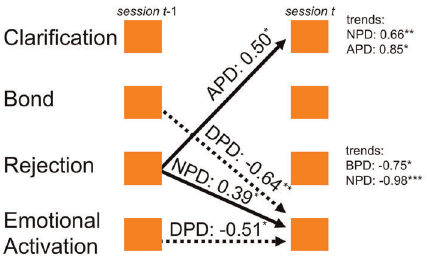
Figure 4. Significant time-lagged associations in diagnostic subsamples. Significant time-lagged associations in diagnostic sub- samples: BPD, borderline PD (n=20); NPD, narcissistic PD (n=35); APD, anxious-avoidant PD (n=16); DPD, dependent PD (n=10). Arrows indicate those time-lagged associations whose means deviate signifi- cantly from zero in the respective subsample. Mean parameter values printed next to arrows (*, p , .05, **, p , .01). Negative associations: dotted arrows. Significant linear trends of the single components are printed right.